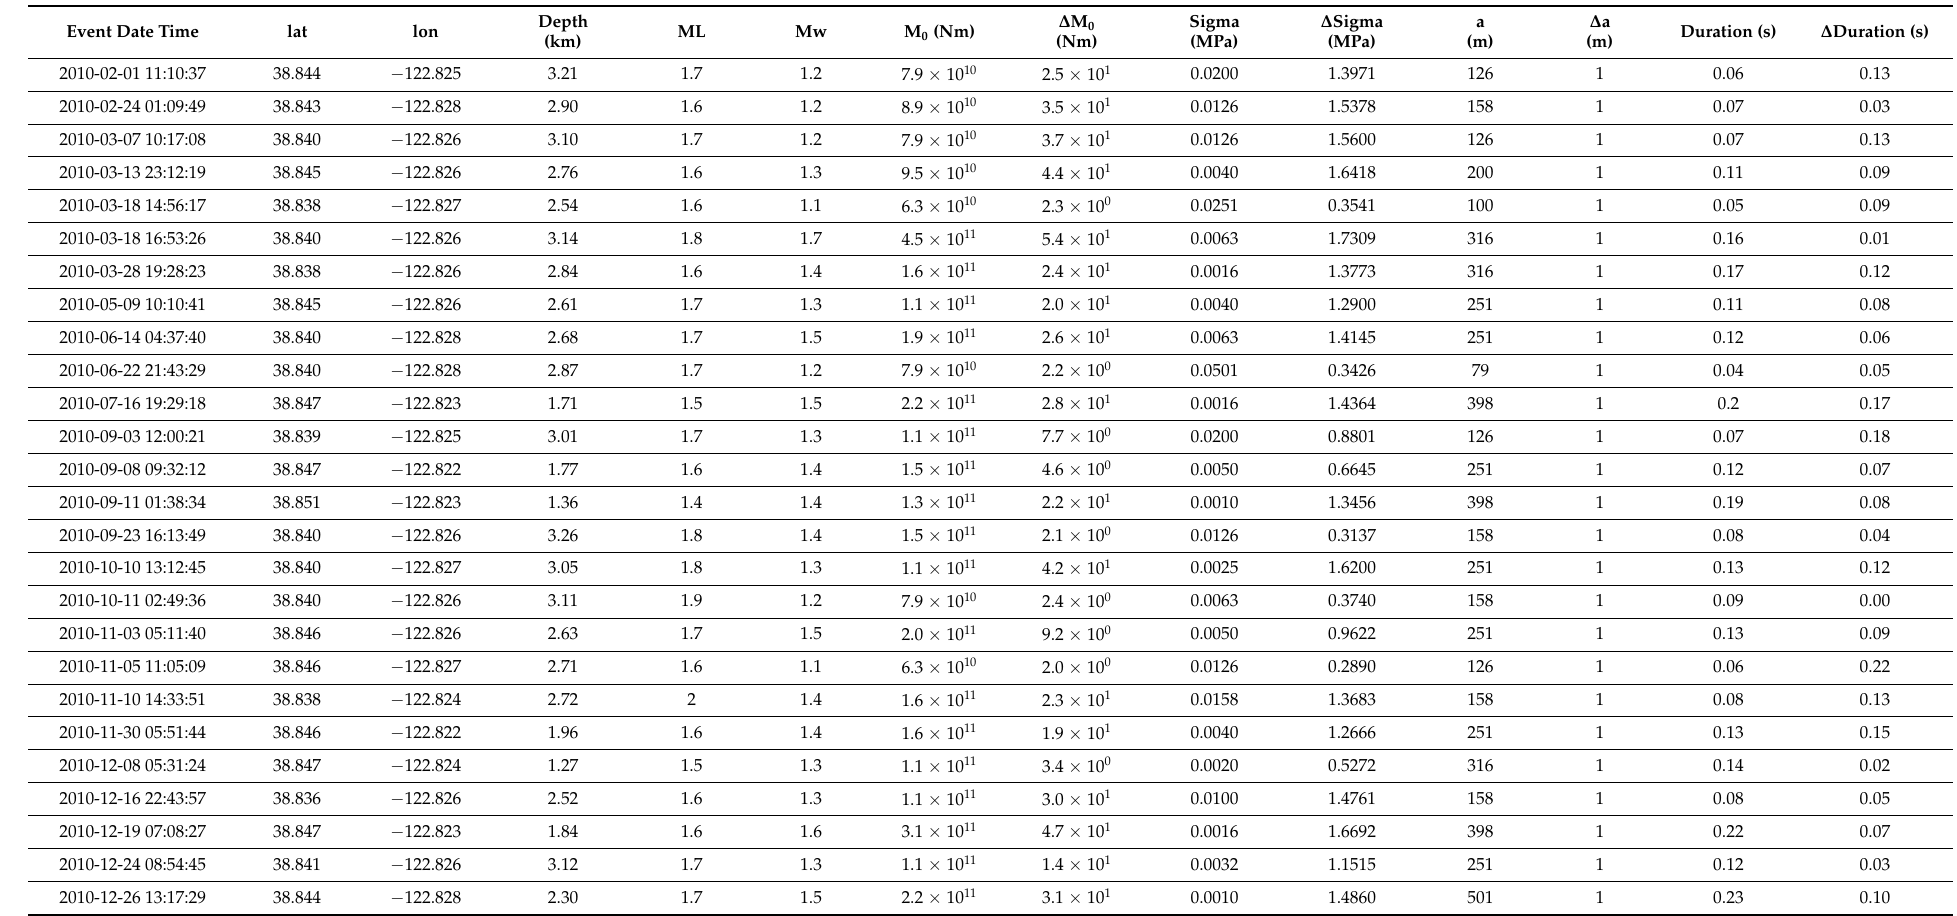
Table A1. Source parameters estimates for the 83 events used in this work. Origin time, location, and local magnitude are inferred from an NCEDC bulletin. Remaining source parameters and their errors are evaluated through our time domain technique. In particular, source duration was obtained from T c measurements of event LPDT